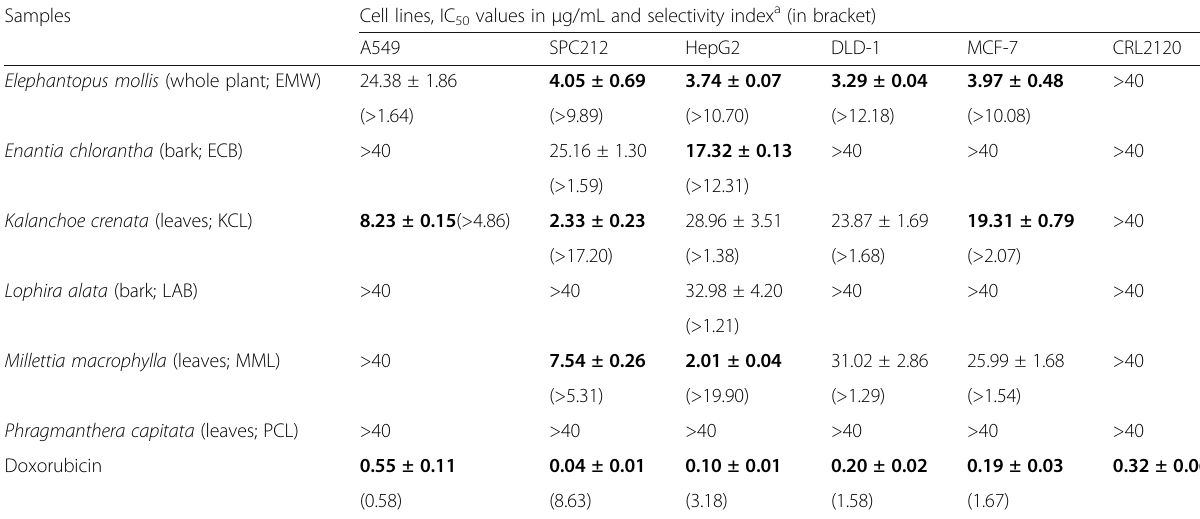
Table 2 Cytotoxicity of tested plant extracts and doxorubicin towards cancer cell lines and normal cells as determined by the neutral red assay